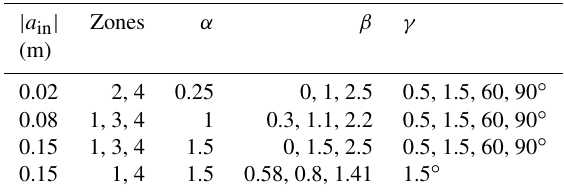
Table 3. ISW parameters from laboratory-scale numerical experi- ments (Terletska et al.,